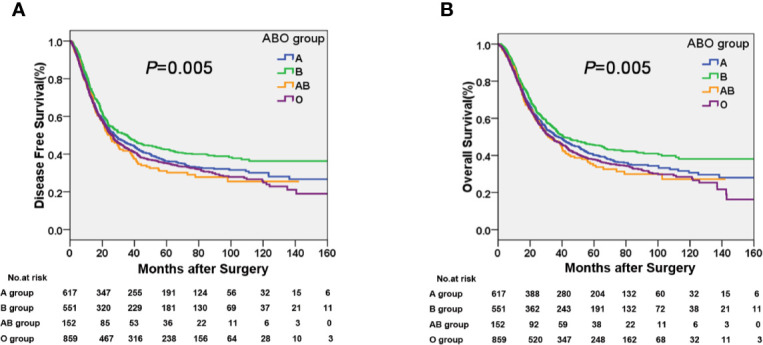
Kaplan-Meier curves showing a significant difference in (A) disease free survival (DFS) and (B) overall survival (OS) among the four ABO blood groups.